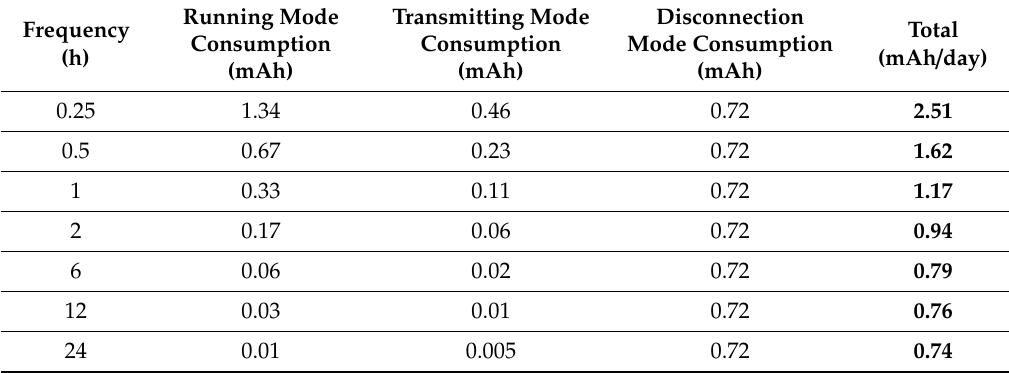
Table 6. Daily energy consumption according to measurement frequency for each function